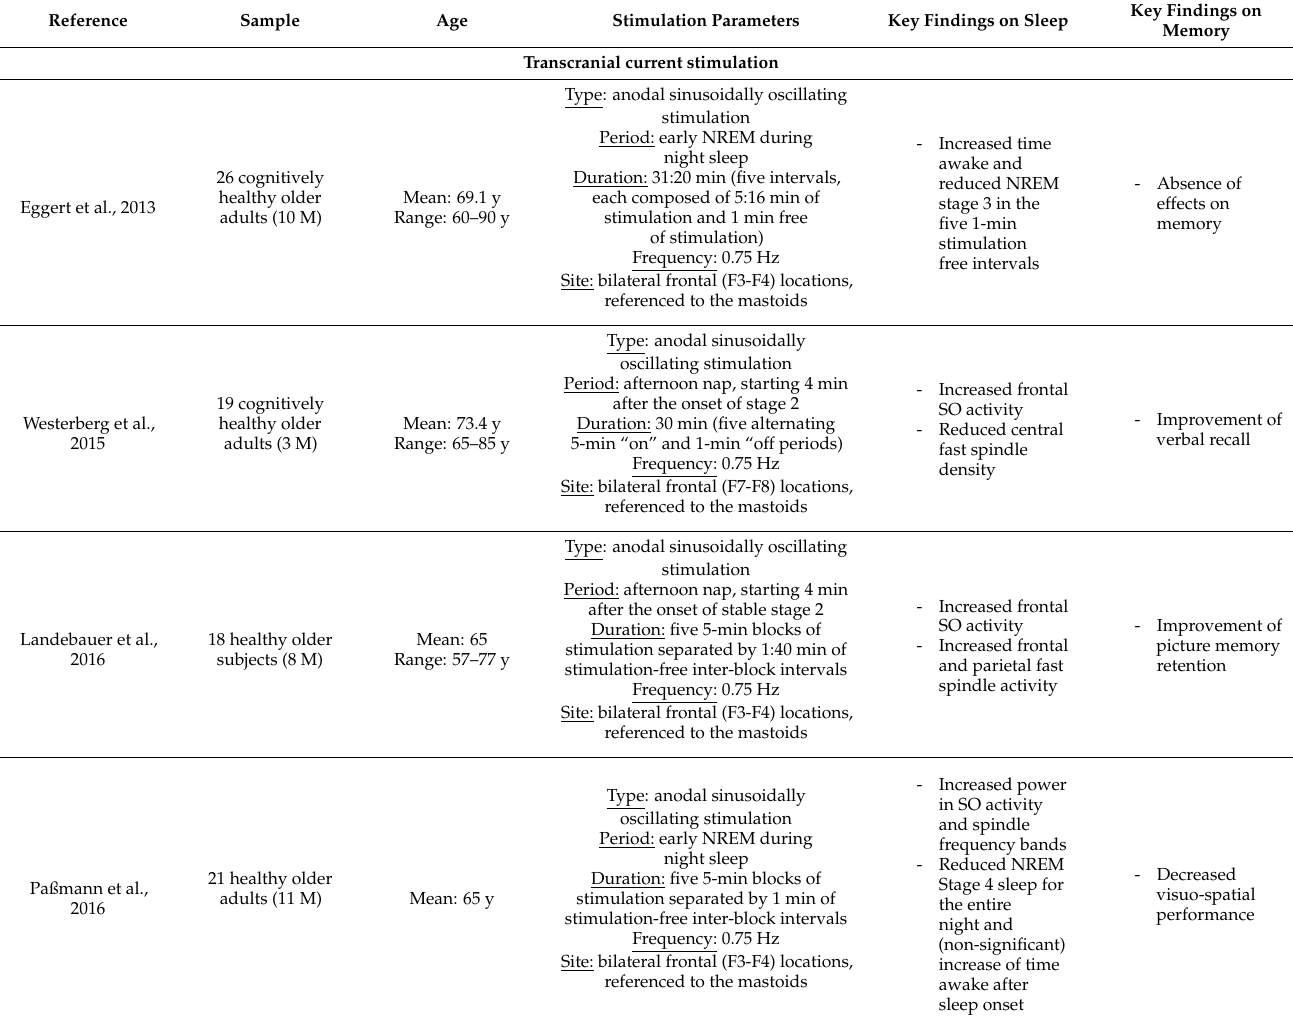
Table 2. Main features and key findings of studies reporting data on the effect of transcranial current stimulation and auditory stimulation techniques on NREM sleep features and memory in healthy and pathological